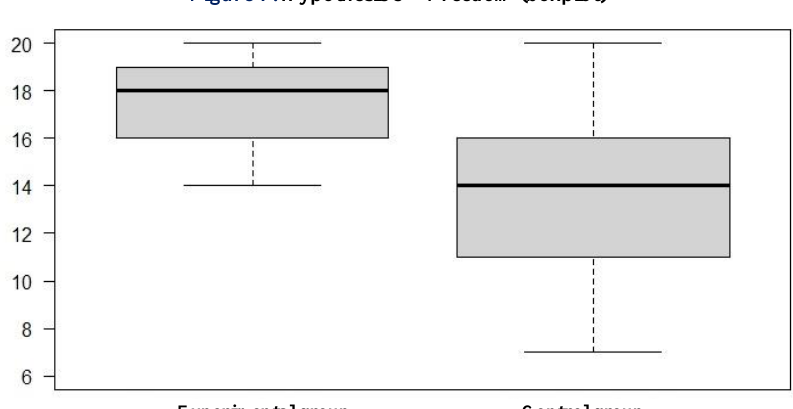
Figure 7. Hypothesis 3 – Freedom (boxplot)